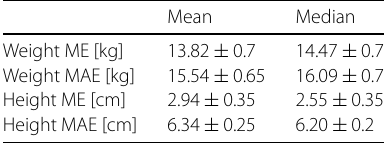
Table 1 Mean error (ME) and mean absolute error (MAE) when aggregating individual estimates via mean and median, with 95% confidence